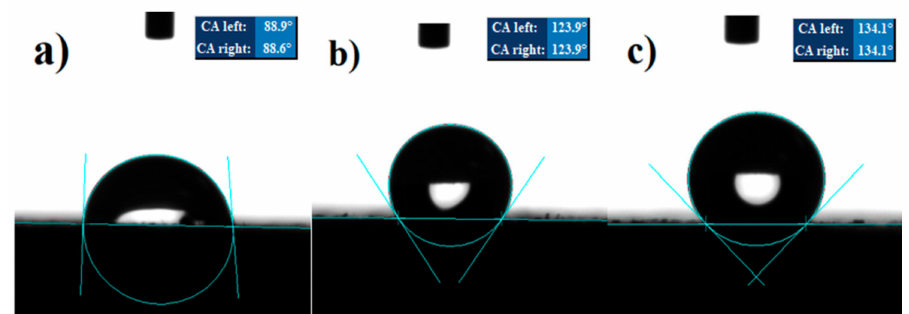
Figure 5. Water contact angles of ( a ) control; ( b ) TiO 2 modified wood; ( c ) ZnO modified wood.